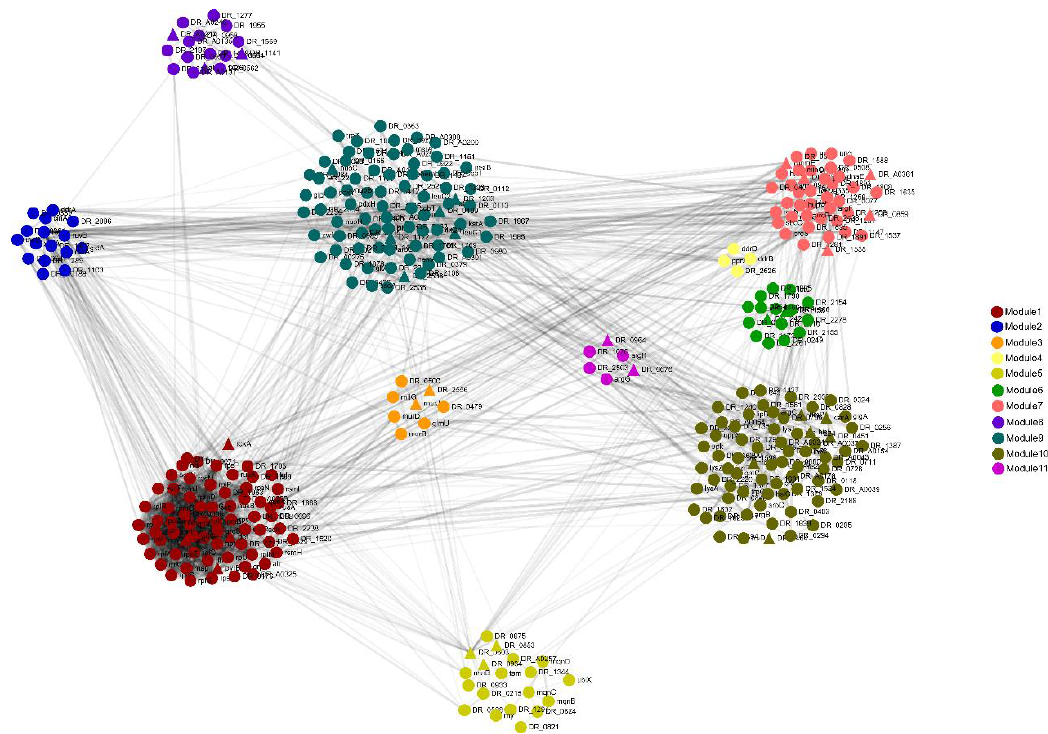
Figure 6. The protein–protein interaction (PPI) network of oxidative stress response proteins in D. radiodurans revealed by functional protein association network (STRING) analysis. A total of 336 differential proteins are shown in the PPI network, with 11 modules indicated in different colors.